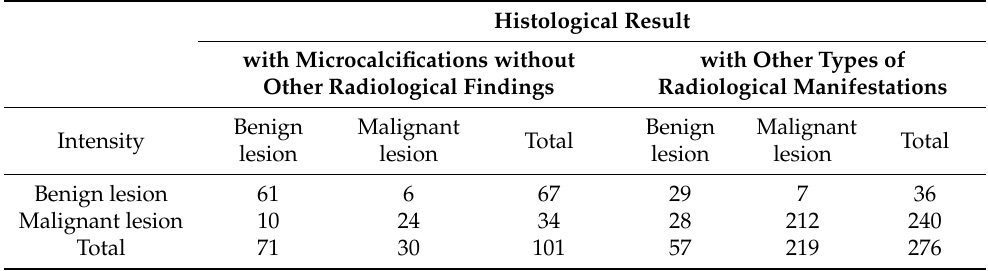
Table 4. Lesion classification according to CESM intensity and histological result (benign vs. any malignant) among lesions with microcalcification without other radiological findings (N = 101) and with other types of radiological manifestations (N = 276). The unenhanced pattern (score 0) was considered predictive of benignity. The minimally, moderately, and markedly enhanced patterns (scores 1, 2, and 3, respectively) were considered predictive of malignancy.